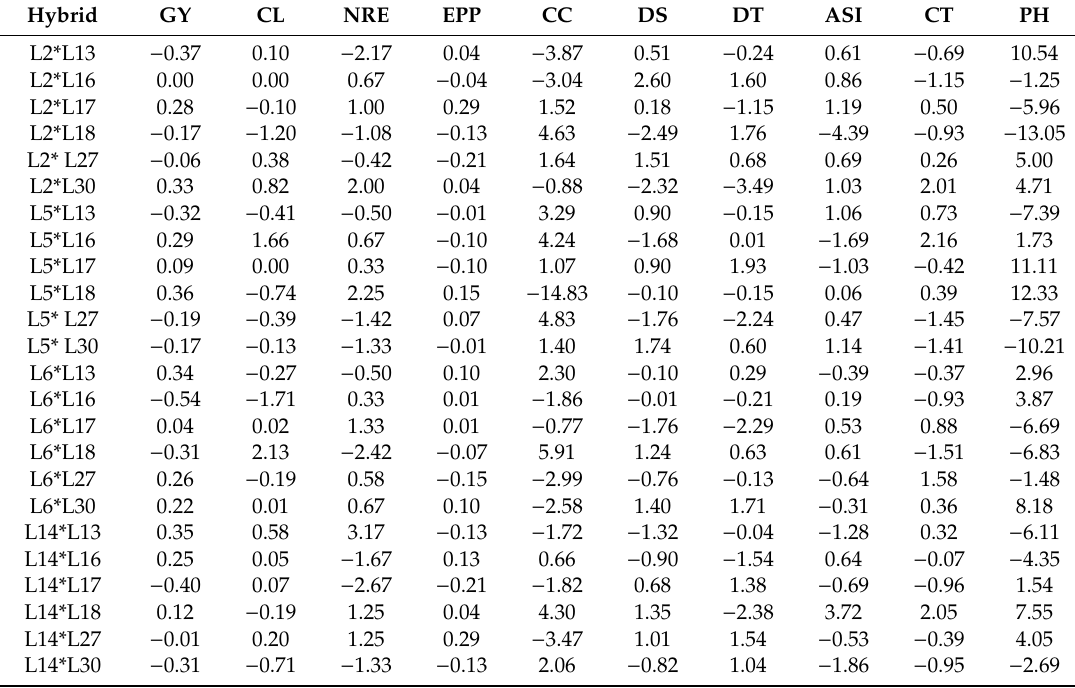
Table 7. Specific combining ability e ff ects for yield, yield components and other morpho-agronomic traits under combined drought and heat-stressed (CDHS)